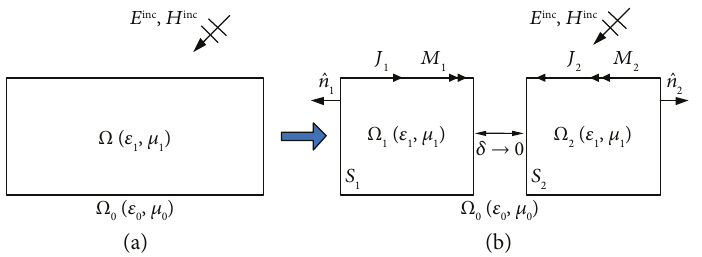
Figure 1: (a) The scattering problem of a three-dimensional dielectric object. (b) The object decomposed into two subdomains using the contact-region modeling